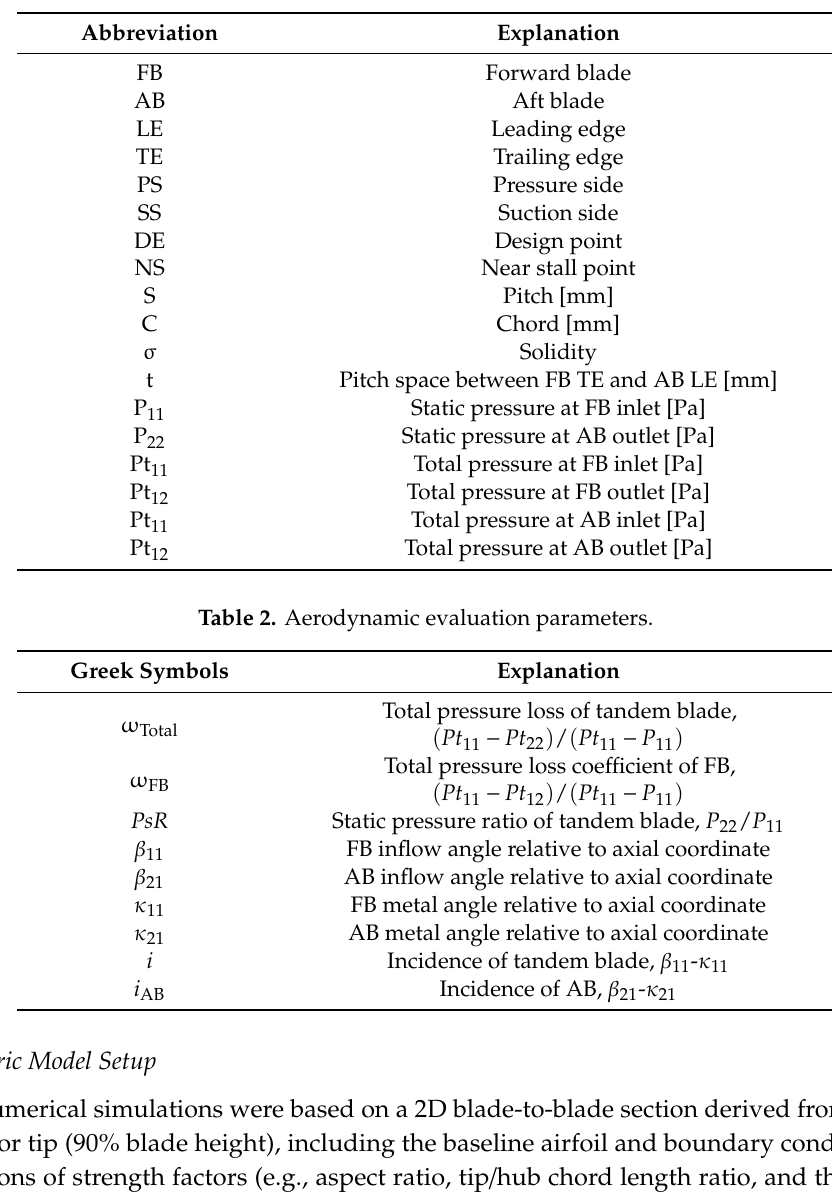
Table 1. Nomenclature and abbreviations.